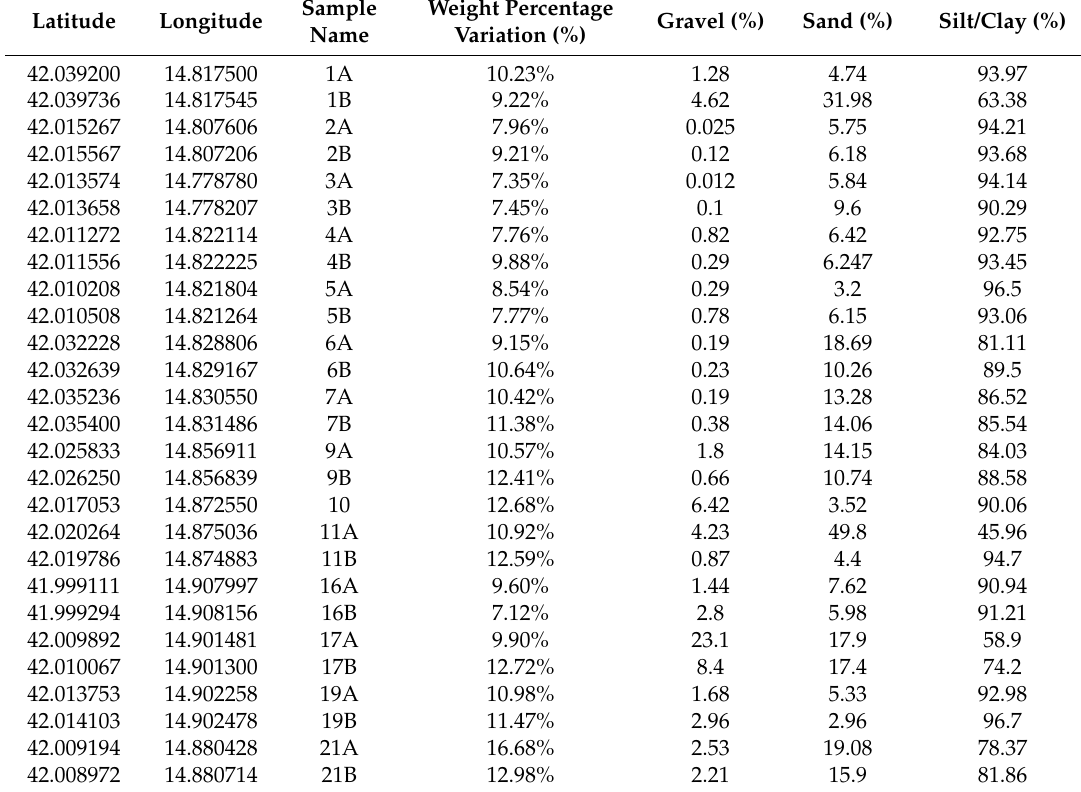
Table 1. Granulometric results of soil samples collected at Petacciato on 12 April 2018 and analyzed at the CNR IMAA laboratory in